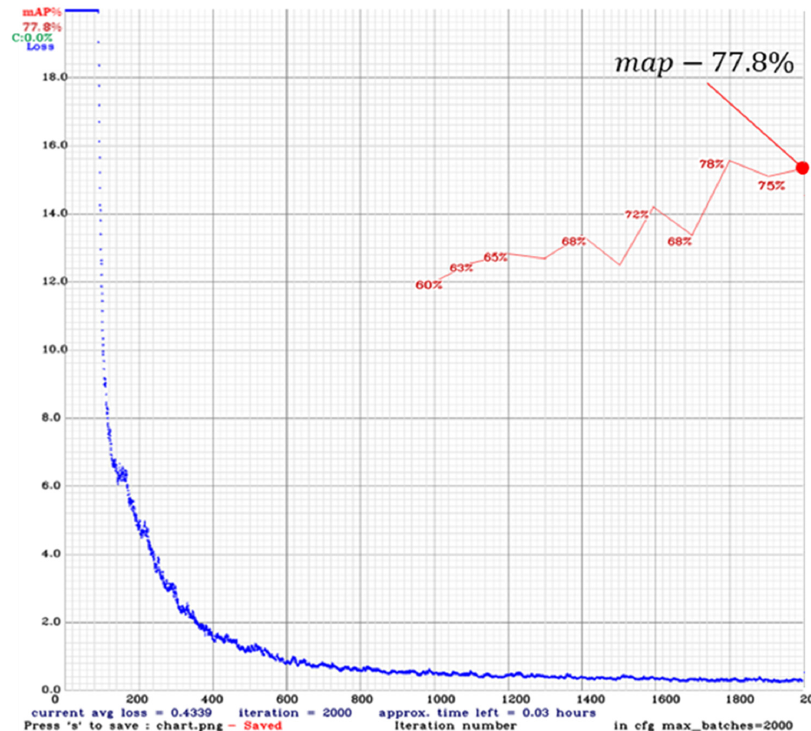
Figure 7. YOLOv2 training graph.